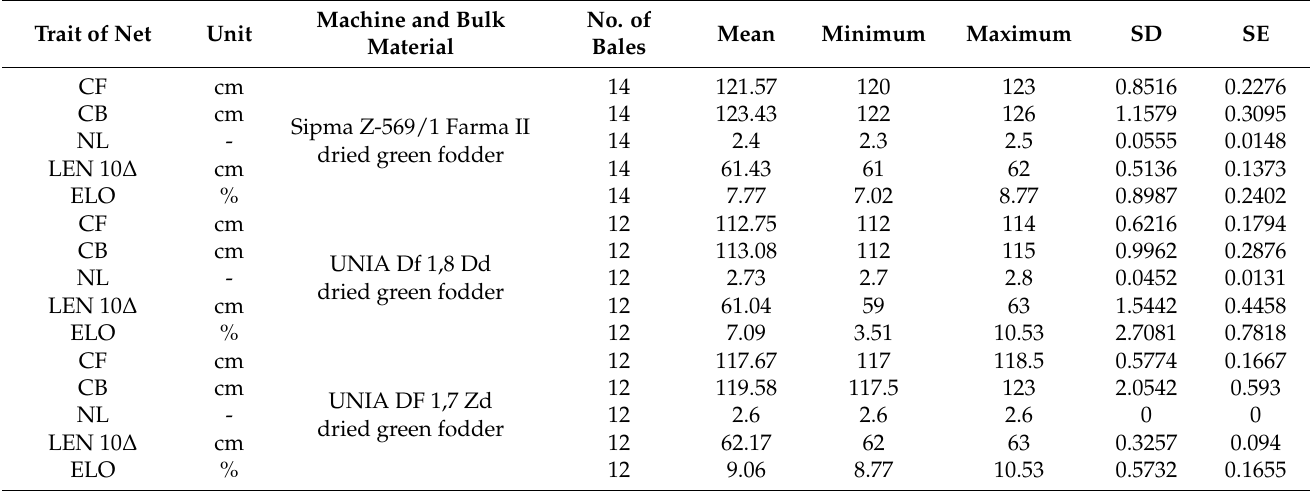
Table 4. Descriptive statistics of round balers collecting dried green